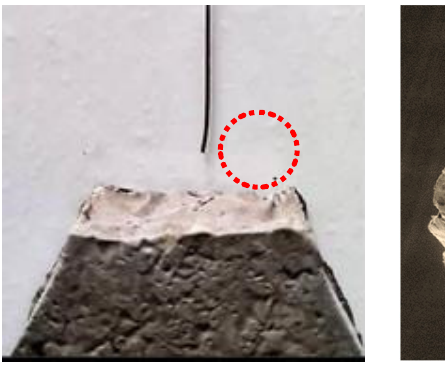
Table 6. Elemental analysis with EDS.